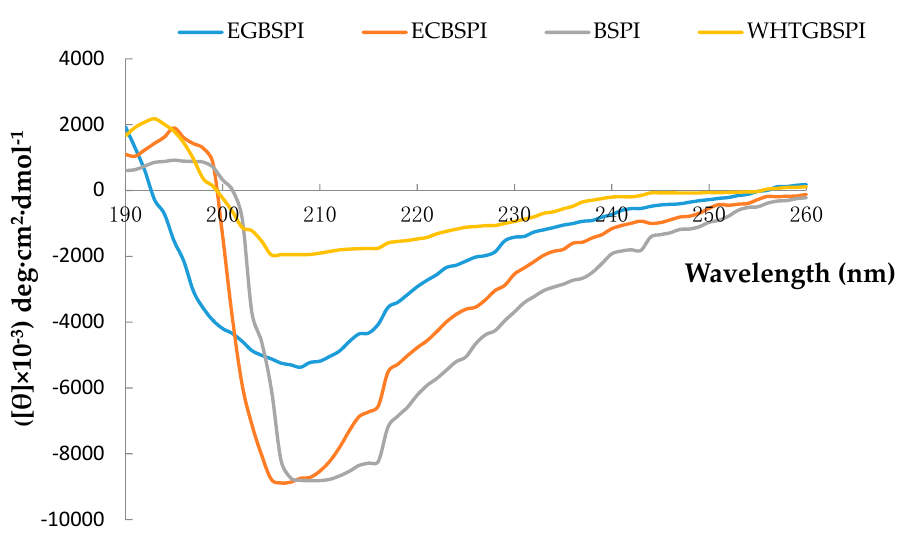
Figure 3. Circular dichroism spectra of BSPI and its modified products.